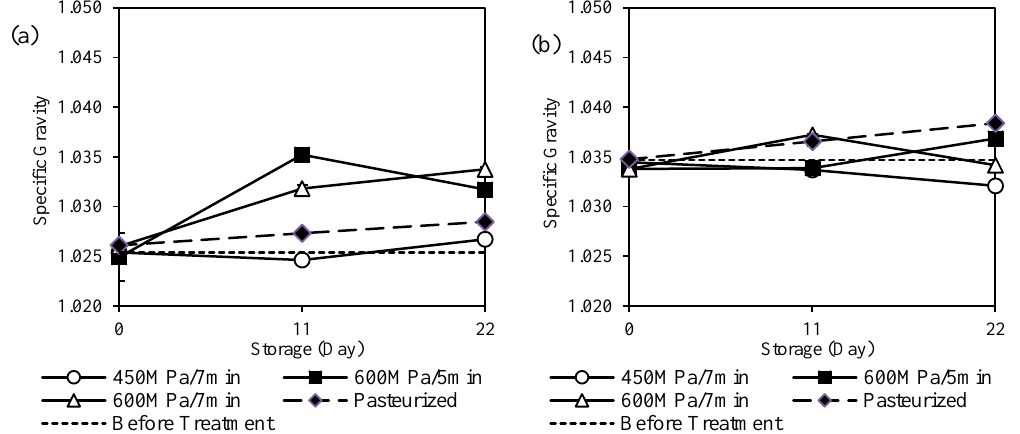
Figure 3. Changes in specific gravity of ( a ) cow and ( b ) goat milk during storage period of 22 days. Solid lines represent HPP-treated milk (450 MPa/7 min, 600 MPa/5 min, 600 MPa/7 min), dashed lines represent pasteurized milk and dotted lines represent fresh milk before treatment.